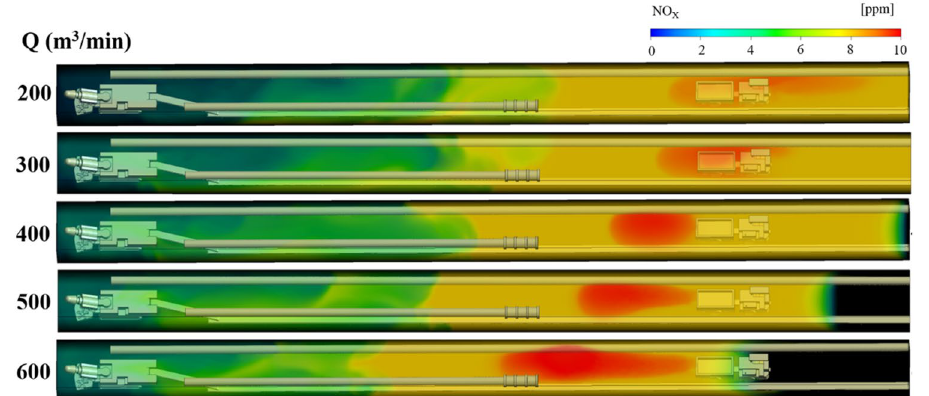
Figure 9. NO x gas distribution under different air volumes Q at L = 60